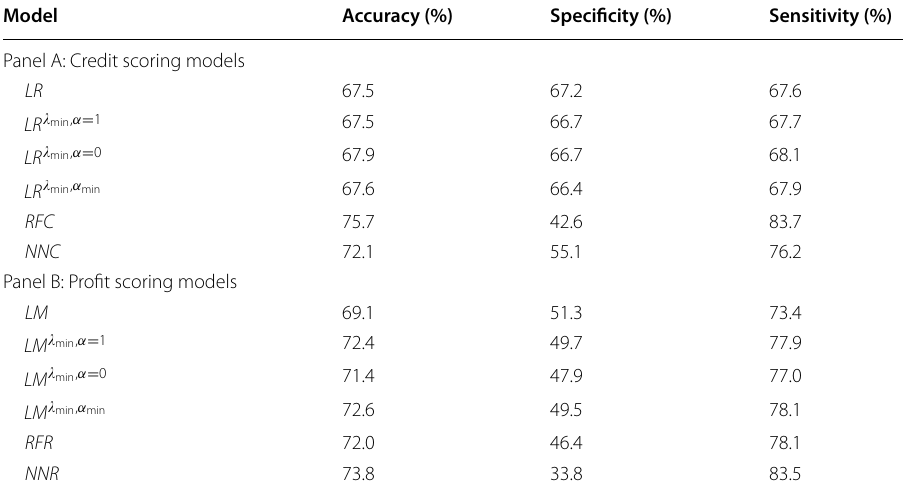
LR (cid:31) min , α = 1 , LR (cid:31) min , α = 0 , LR (cid:31) min , α min are lasso, ridge and elastic net version of logistic regression, LM (cid:31) min , α = 1 , LM (cid:31) min , α = 0 , LM (cid:31) min , α min are lasso, ridge and elastic net version of linear regression RFC random forest classification, NNC neural network classification, RRR random forest regression, NNR neural network